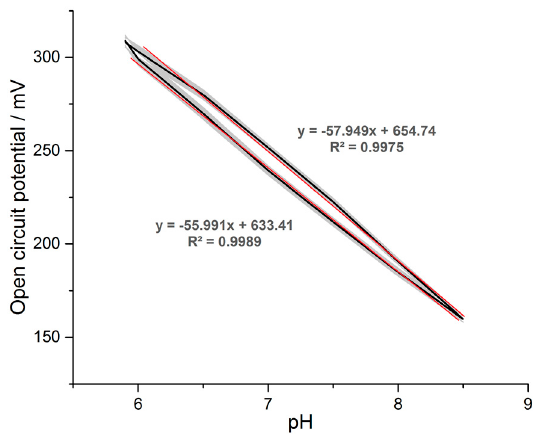
Figure 19. Hysteresis plot of the pH vs. open circuit potential recorded during the stability test. Grey area indicates the standard deviation of the repeated pH series with trend lines. The average Nernstian slope of the pH curve is − 57.301 mV/pH.